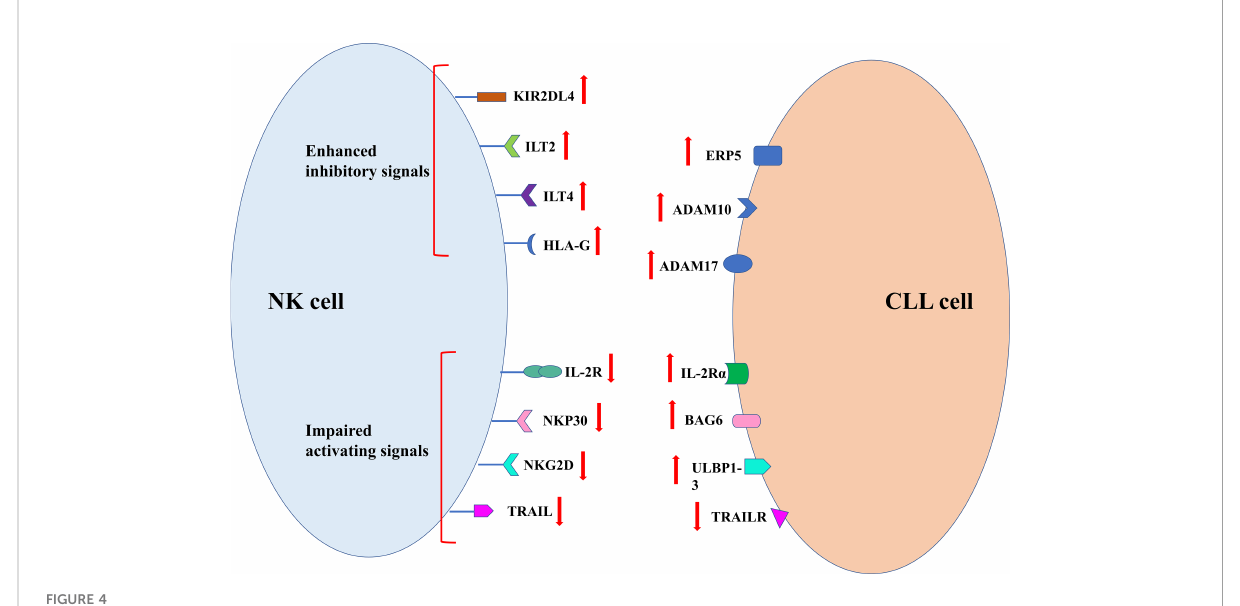
FIGURE 4 Mechanism of tumor escape from NK cell immune